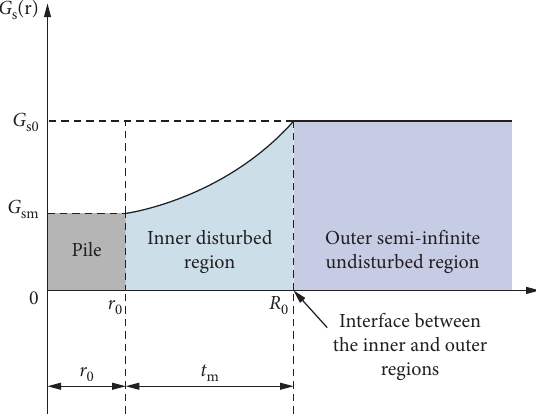
Figure 2: Diagrammatic sketch of the radially inhomogeneous